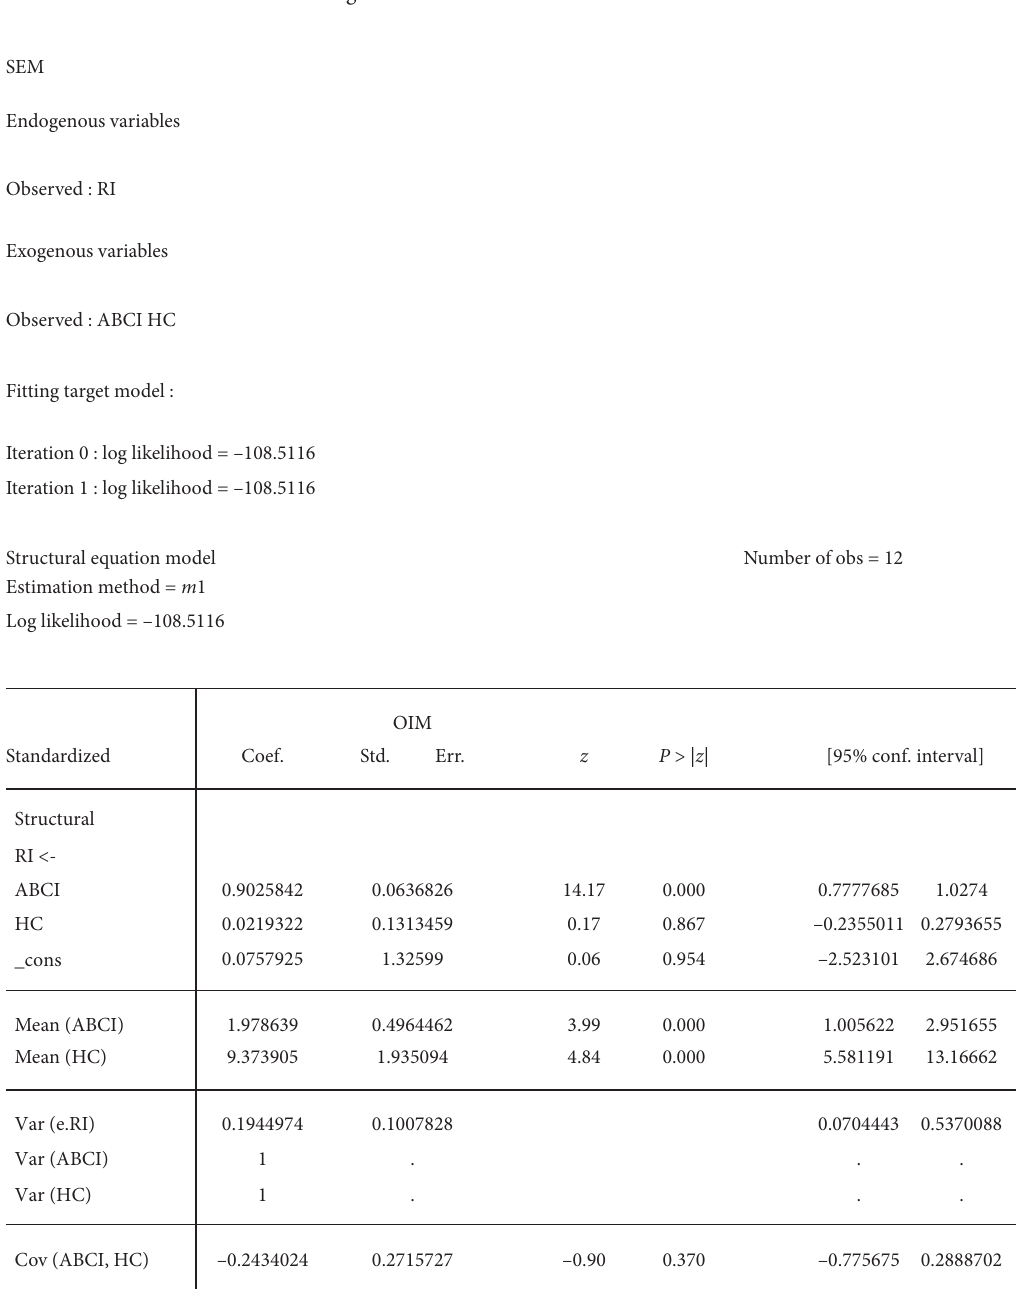
Figure 8: The magnitude of the effectiveness of ABCI and RI over